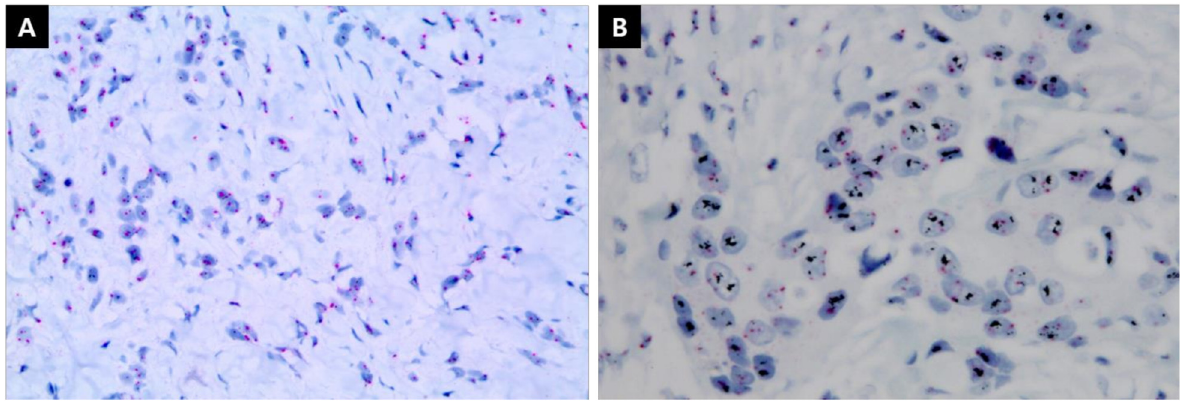
Figure 5. Silver in situ hybridization (SISH) evaluation to determine HER2 overexpression in breast cancer. ( A ) SISH- negative and ( B ) SISH-positive. ( × 400) Scale bar or